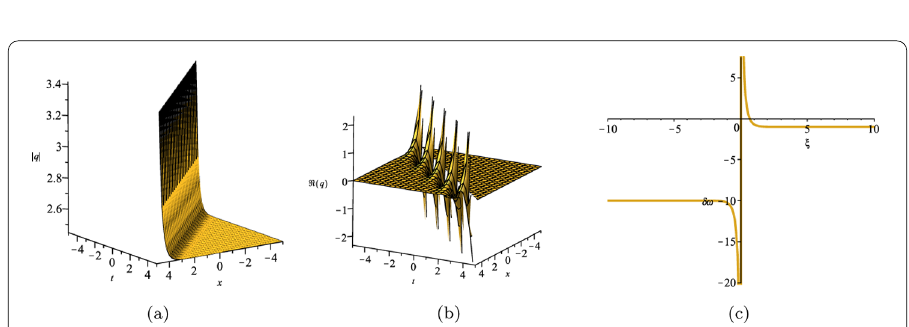
Figure 2 Chirped singular soliton solution (21) with a 1 = 4, a 2 = 1, b = 2, α = 2, λ = 6, μ = 1, ν = 1, σ = 2, Ω = 3. ( a ) Modulus. ( b ) Real part. ( c ) Corresponding chirp